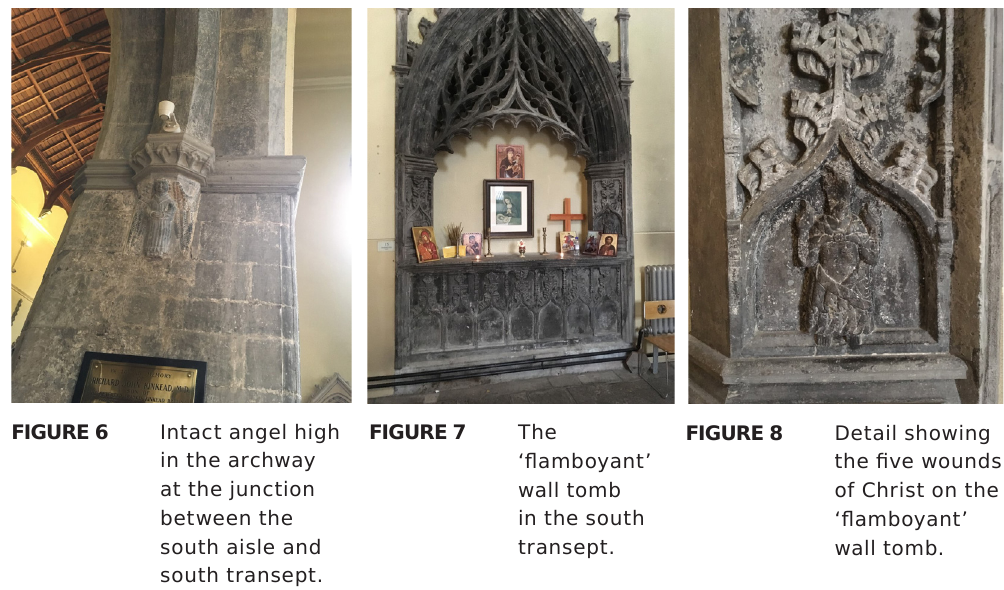
Figure 8 Detail showing the five wounds of Christ on the ‘flamboyant’ wall